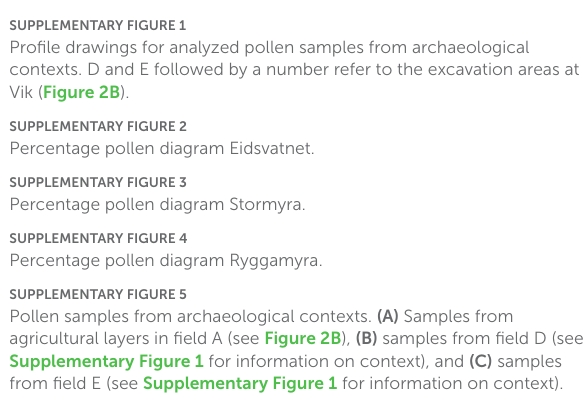
SUPPLEMENTARYFIGURE2 Percentage pollen diagram Eidsvatnet. SUPPLEMENTARYFIGURE3 Percentage pollen diagram Stormyra. SUPPLEMENTARYFIGURE4 Percentage pollen diagram